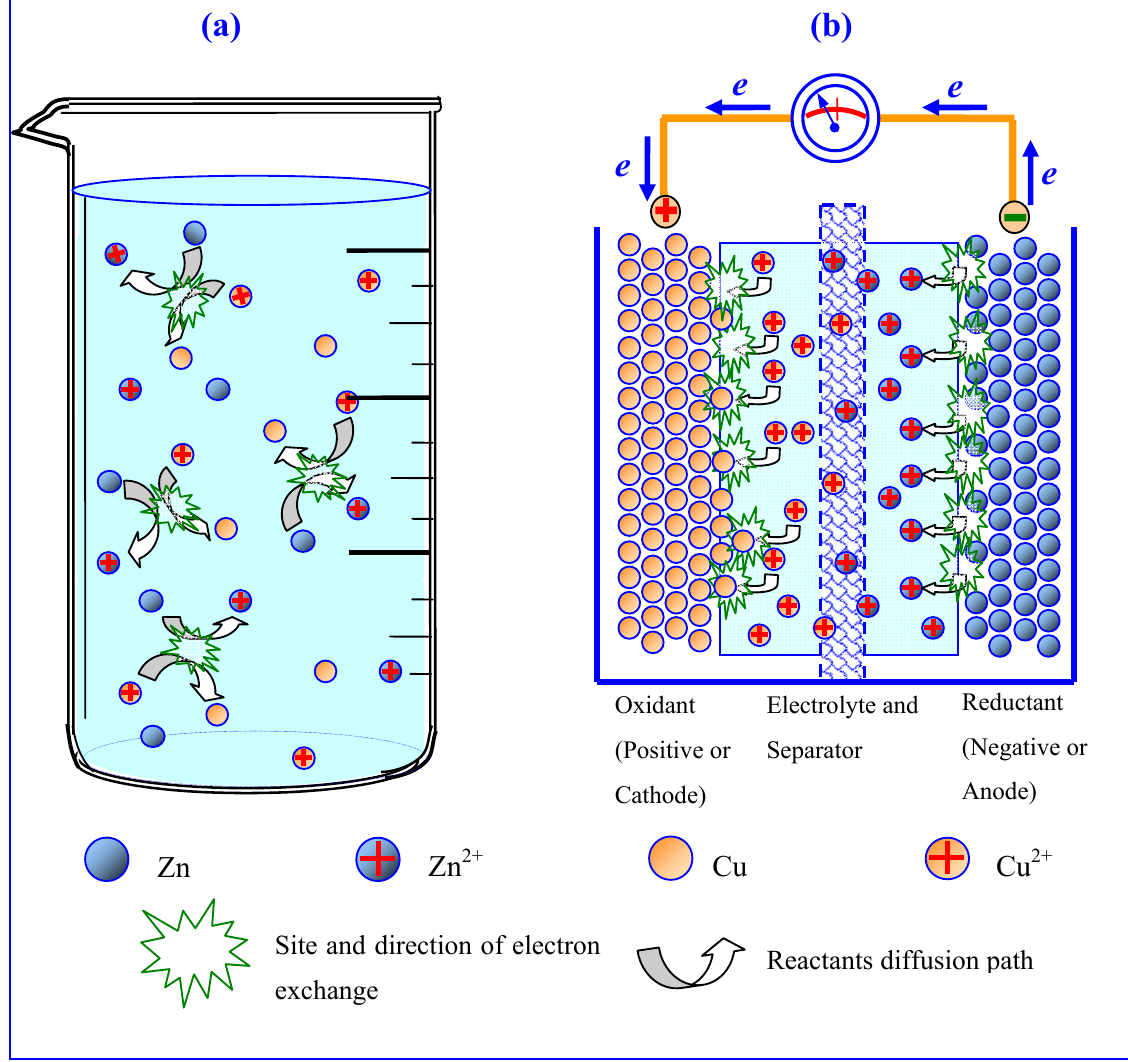
Figure 1. Interface distinguishes electrochemistry from conventional chemistry: (a) chaotic collision of reactant particles leads to dissipation of free energy in the form of heat; (b) interfaces between electrode/electrolyte force reactions to proceed in an orderly manner, thus producing orientation movement of electrons in a Daniel cell (reproduced with permission from The Elsevier Encyclopedia of Electrochemical Power Sources , © Elsevier, November